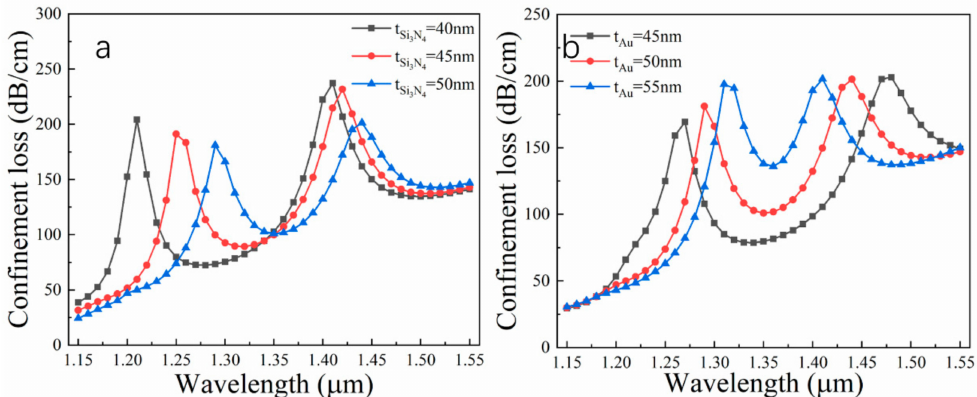
Figure 5. Dependence of loss spectra on di ff erent film thicknesses: ( a ) Si 3 N 4 layer; ( b ) gold layer when d 1 = 0.70 µ m, d 2 = 0.45 µ m, Λ = 1.60 µ m and n =